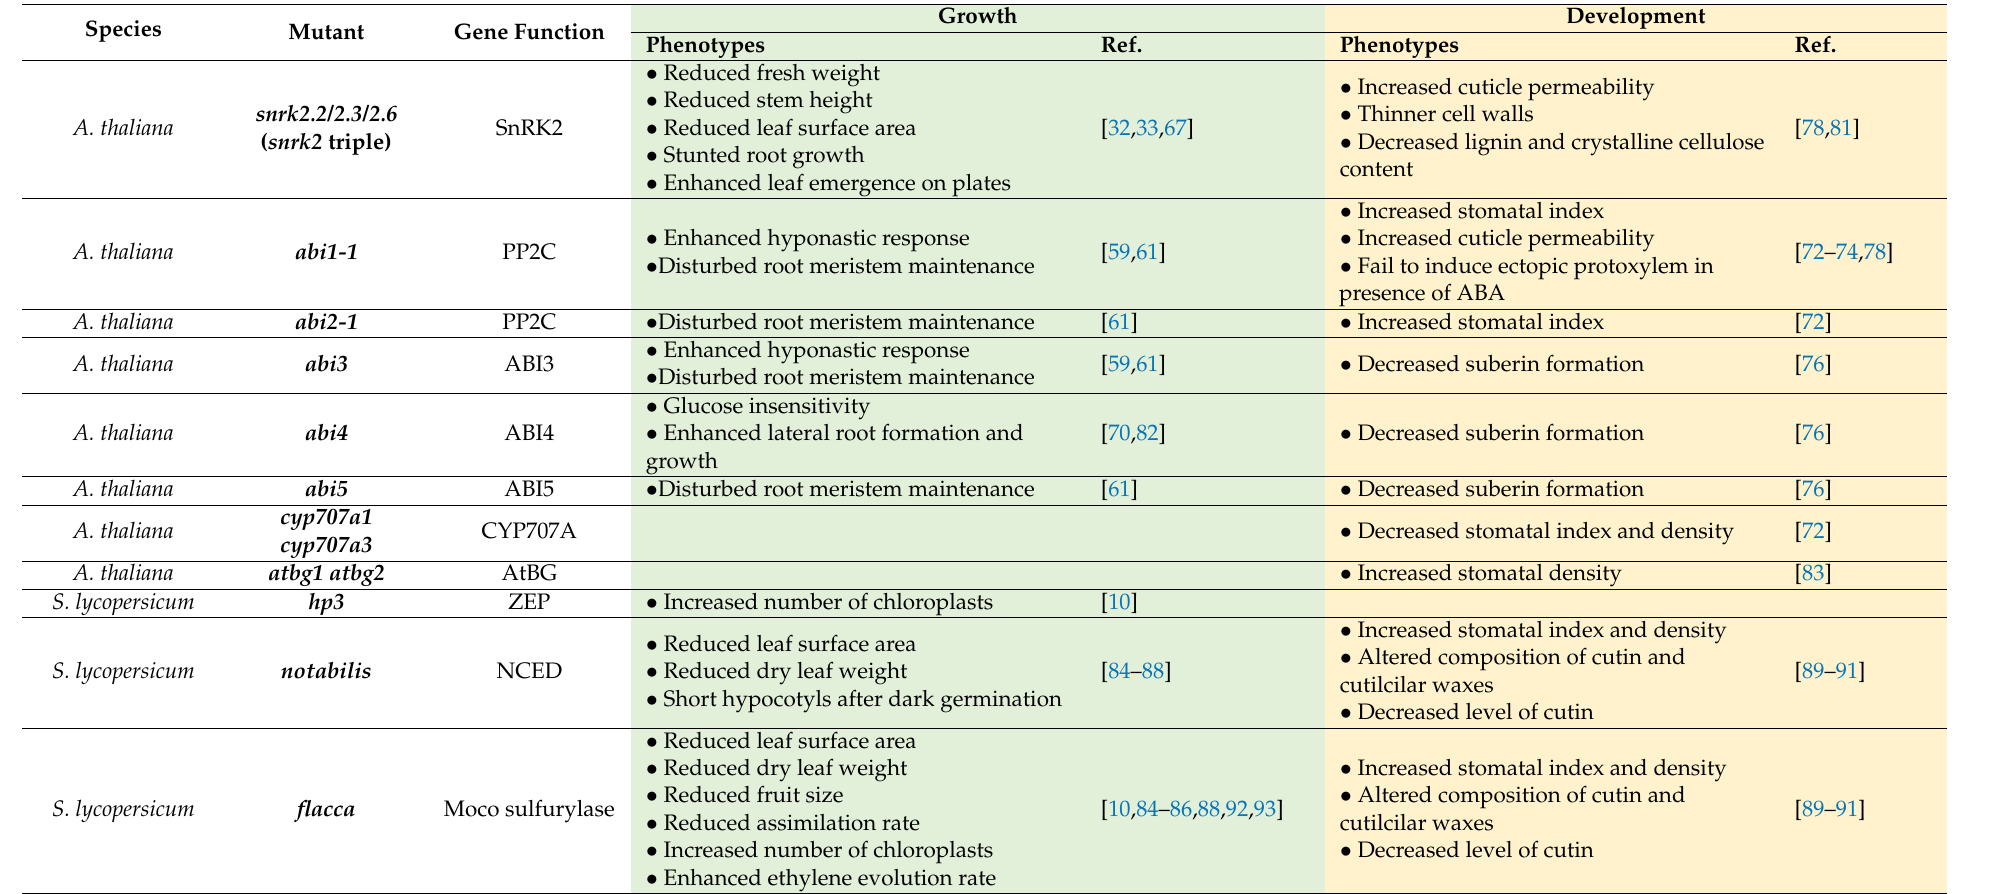
Growth Development Species Mutant Gene Function Phenotypes Ref. Phenotypes